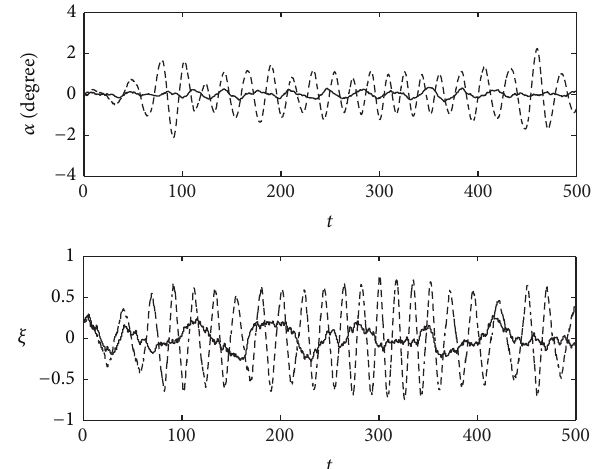
Figure 9: Time histories for system (8) with IC = [1 ∘ ,0,0,0] . Parameters are 𝑈/𝑈 𝑓 = 0.8 and 𝜂 = 8 (solid lines) or 𝜂 = 100 (dashed lines).